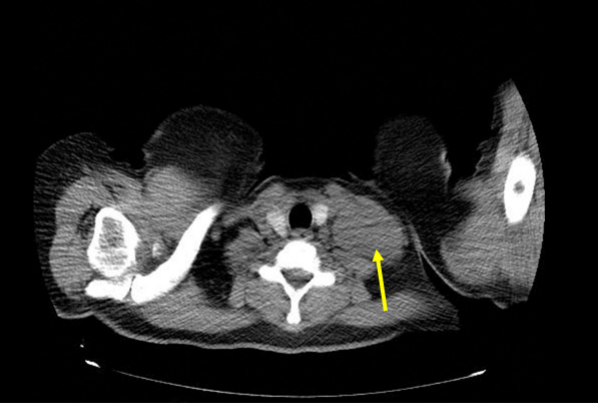
Figure 2. Chest CT scan. A soft tissue mass in the left supraclavicular region consistent with metastatic lymph node (yellow